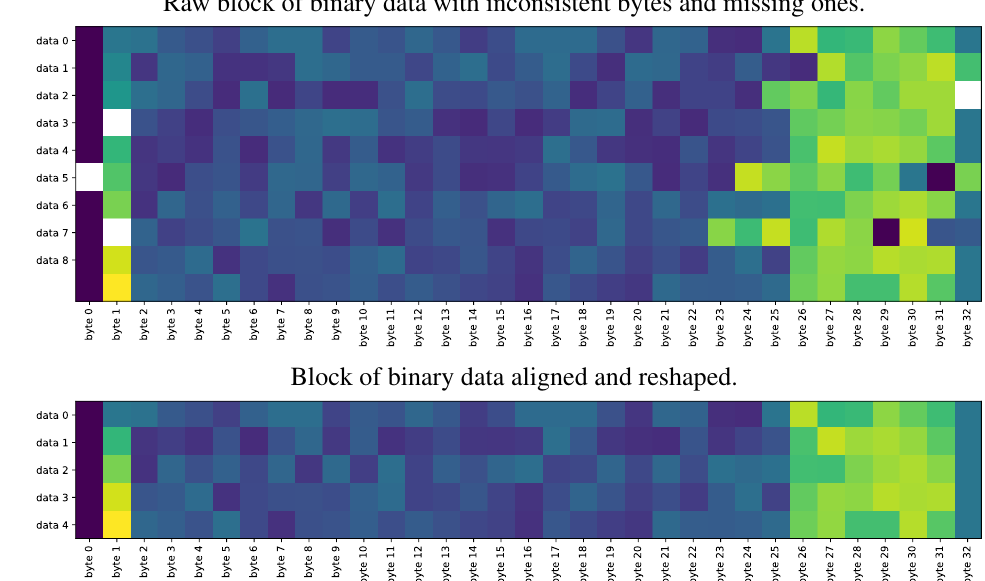
Figure 3. Proposed OpenBCI Cyton-based data block deserialization. Data deserialization must guarantee a data context to avoid overflow in subsequent conversion. The first block of columns, from 2 to 26, contains the EEG data, and the remaining ones, e.g., 26 to 32, gather the auxiliary data. Table 5. OpenBCI Cyton configurations using Daisy expansion board and a Wi-Fi